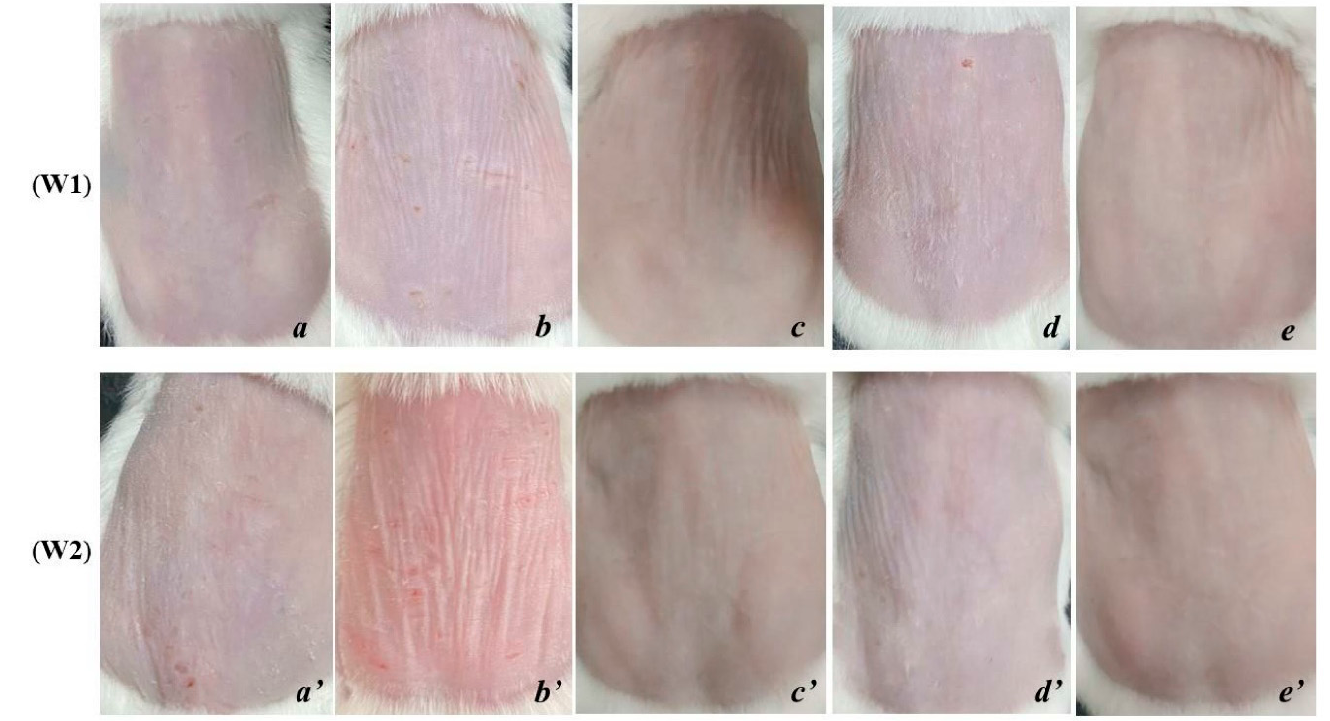
Figure 2. Mouse skin after 1 and 2 weeks of applying the experimental product (W1—after 1 week; W2—after 2 weeks; ( a , a’ )—PC; ( b , b’ )—NC; ( c , c’ )—OB; ( d , d’ )—ME; ( e , e’ )—SR). ( a ) PC, wrinkles are more and more obvious, ( a’ ) wrinkles are more and deeper. ( b ) NC, many and deep wrinkles; ( b’ ); dry, vulnerable skin, many and deep wrinkles. ( c ) OB, smooth, even skin tone, few wrinkles but deep; ( c’ )—smooth skin, few and shallow wrinkles. ( d ) ME, dry skin, many and shallow wrinkles; ( d’ )—few wrinkles, shallow, smooth skin. ( e ) SR, skin color is relatively uniform, smooth and with few wrinkles; ( e’ )—smooth skin, few or no wrinkles.